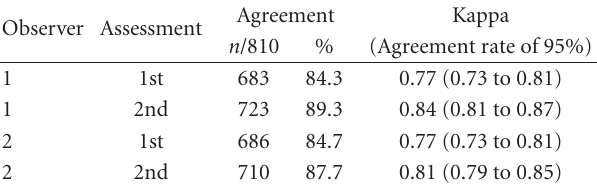
Table 5: Evaluation of agreement between the gold standard with each observer and assessment, in the study of loci numbers.